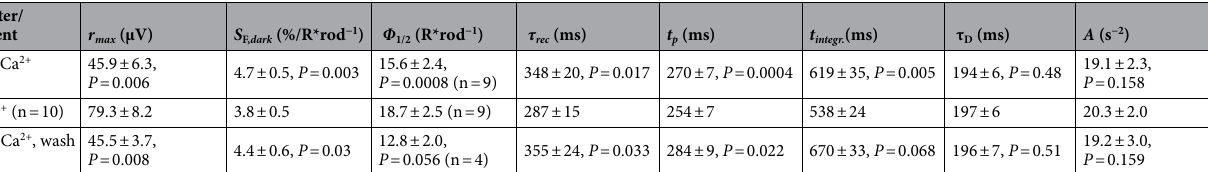
Table 1. Parameter values determined from responses recorded by LERG-OS first in normal Ca 2+ and then in low Ca 2+ from 10 experiments. In 5 experiments, responses were also recorded in normal Ca 2+ after the washout of low Ca 2+ solution. r max , saturated response amplitude measured from the LERG-OS response plateau level; S F,dark , Fractional sensitivity, dim flash response amplitude divided with the strength of the flash stimulus and saturated response amplitude; Φ 1/2 , half-saturating flash strength; τ rec , time constant of single exponential fit to the recovery phase of dim flash responses; t p , time-to-peak of dim flash response; t integr , integration time of dim flash response calculated by taking the integral from time of the flash stimulus to the time when the response has completely recovered and dividing the value with the maximal amplitude of the dim flash response; τ D , the dominant time constant of saturated response recovery obtained from Pepperberg plot; A , amplification constant determined by fitting the flash response model to the response leading edges (Eq. (15)) of response families from individual experiments, as shown in Fig. 2. The lifetime of light-activated rhodopsin was locked to 28 ms in normal Ca 2+ and to 26 ms in a low Ca 2+ solution. The statistical significance was tested using two-tailed paired student’s t-test. The parameters derived in normal Ca 2+ were first compared to those derived in low Ca 2+ and secondly the parameters derived in normal Ca 2+ after the washout were compared to low Ca 2+ parameters derived in the experiments were the washout was performed. The parameter values are presented as mean ±